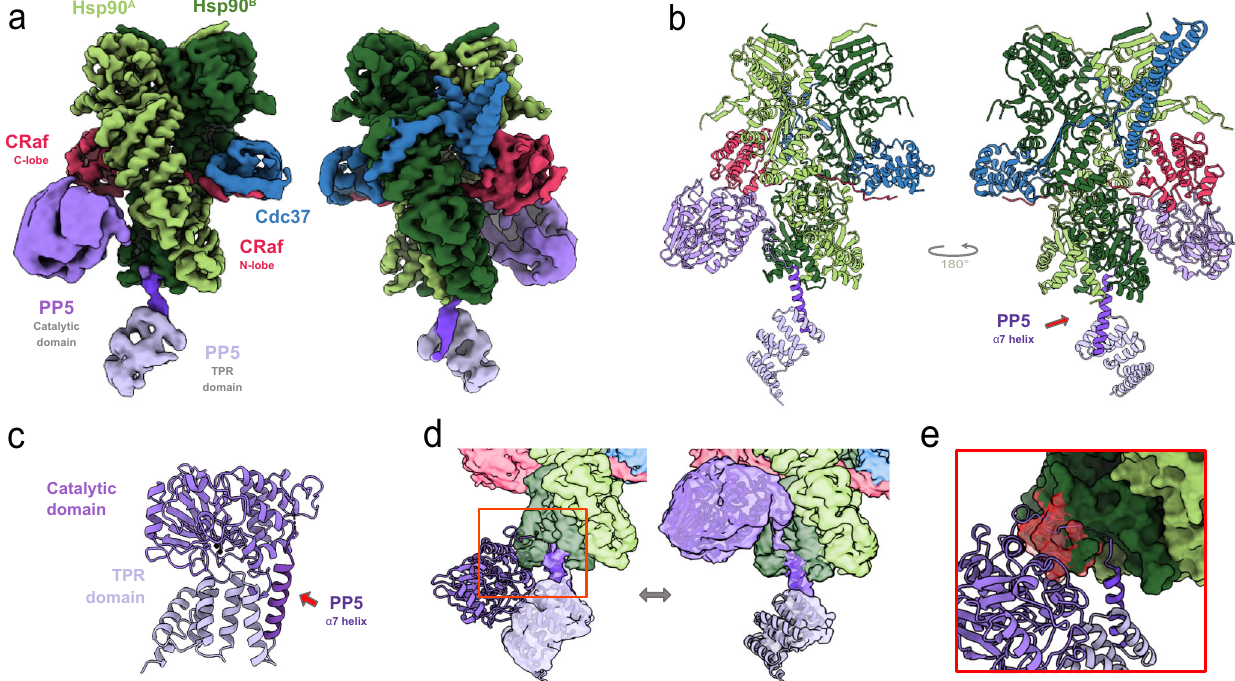
Fig. 2 | Hsp90 activates PP5, acting as a phosphatase scaffold. a Cryo-EM composite map and Hsp90:Cdc37:CRaf:PP5 complex model ( b ) show unfolded CRaf kinase (magenta) threaded through the closed Hsp90 dimer lumen (green), and embraced by Cdc37 (blue). PP5 isin an active conformation asits TPR domain (lavender)interactswiththeHsp90CTDs,whilethePP5catalyticdomain(purple)is